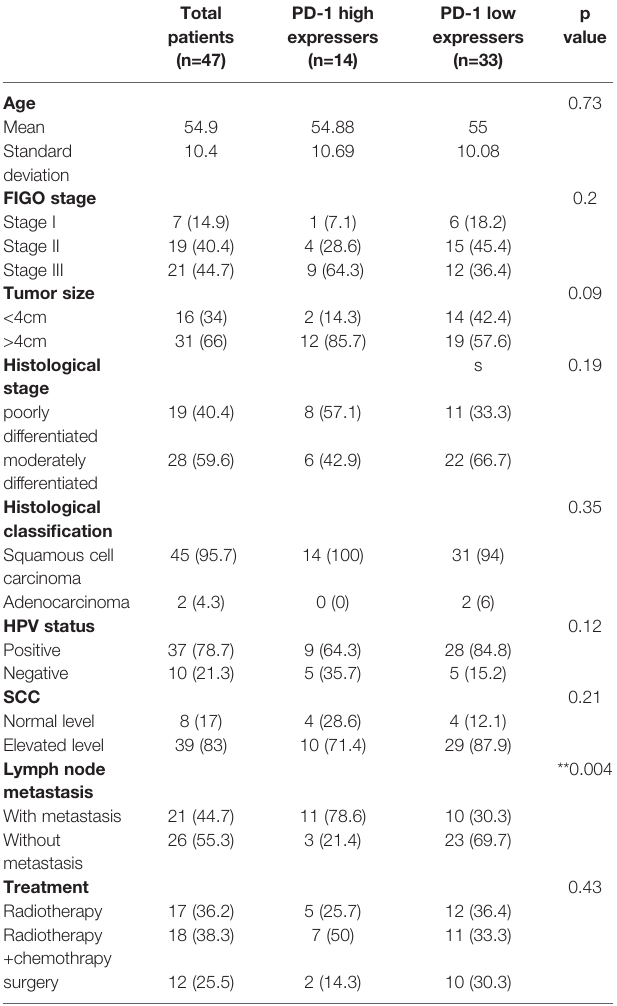
TABLE 1 | Clinical and histopathological characteristics of cervical patients in the cohort. Total